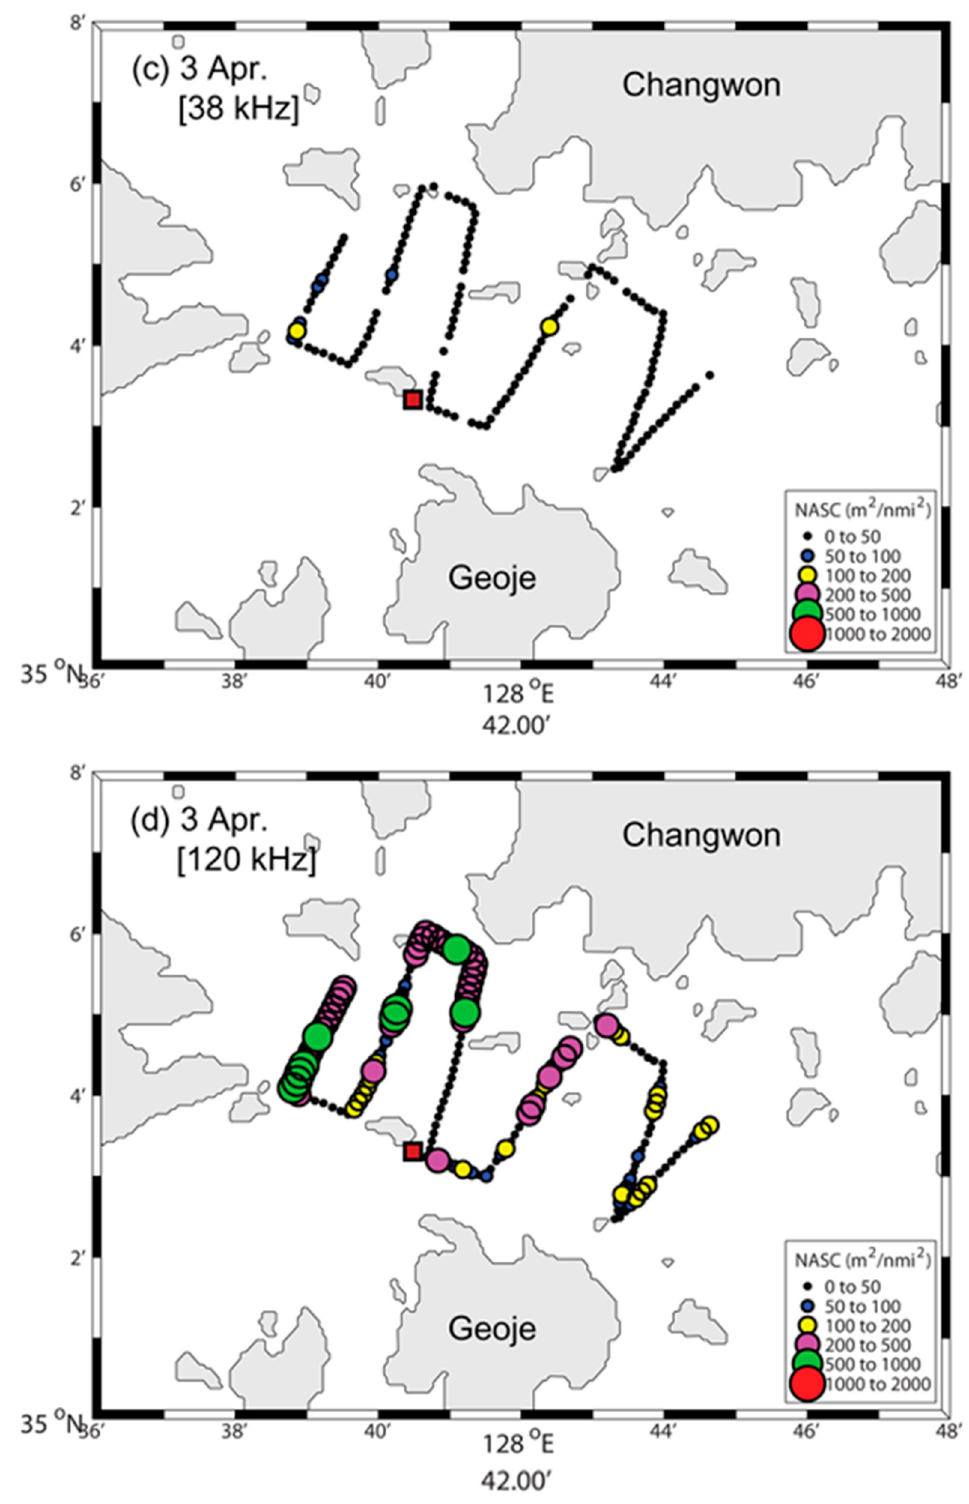
Figure 6. Acoustic backscatter observed in Jinhae Bay. The circles correspond to the observed fish aggregation backscatter using the nautical area scattering coefficient (NASC, m 2 nmi − 2 ) data with a 0.1 nautical mile interval at 38 kHz ( a ) and 120 kHz ( b ) on 20 January 2018, and at 38 kHz ( c ) and 120 kHz ( d ) on 3 April 2018. The location of the echosounder mooring is indicated by a red square. A scale bar is provided at the bottom of the figure. The survey data and frequencies are listed on each panel. NASC: nautical area scattering